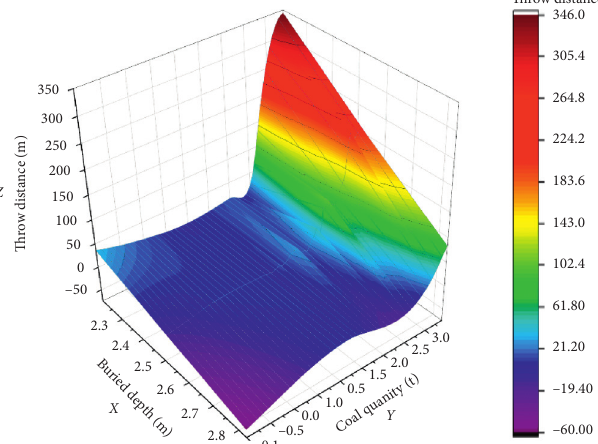
Figure 8: 3D colormap surface of buried depth, coal quantity, and throw distance ( XYZ log